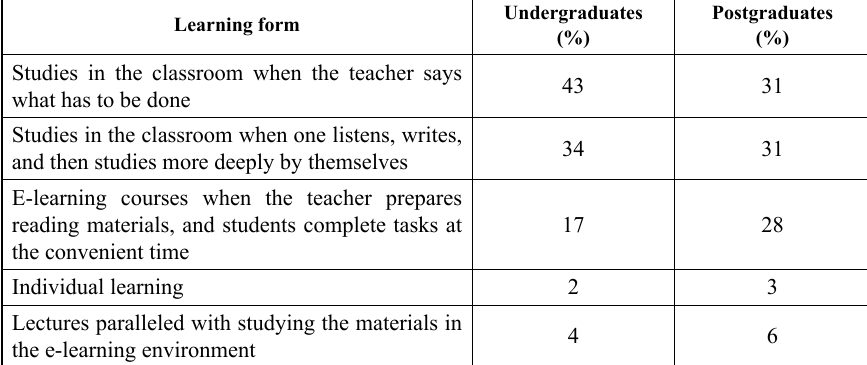
Table. Distribution of students’ evaluations of the effectiveness of different learning